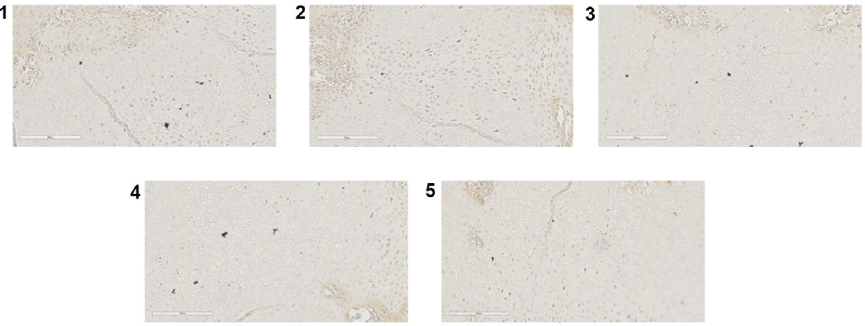
Figure A1. TNF α ( 1 ), MIP-1 α ( 2 ), VEGF ( 3 ), MMP-13 ( 4 ), and BMP2 ( 5 ).